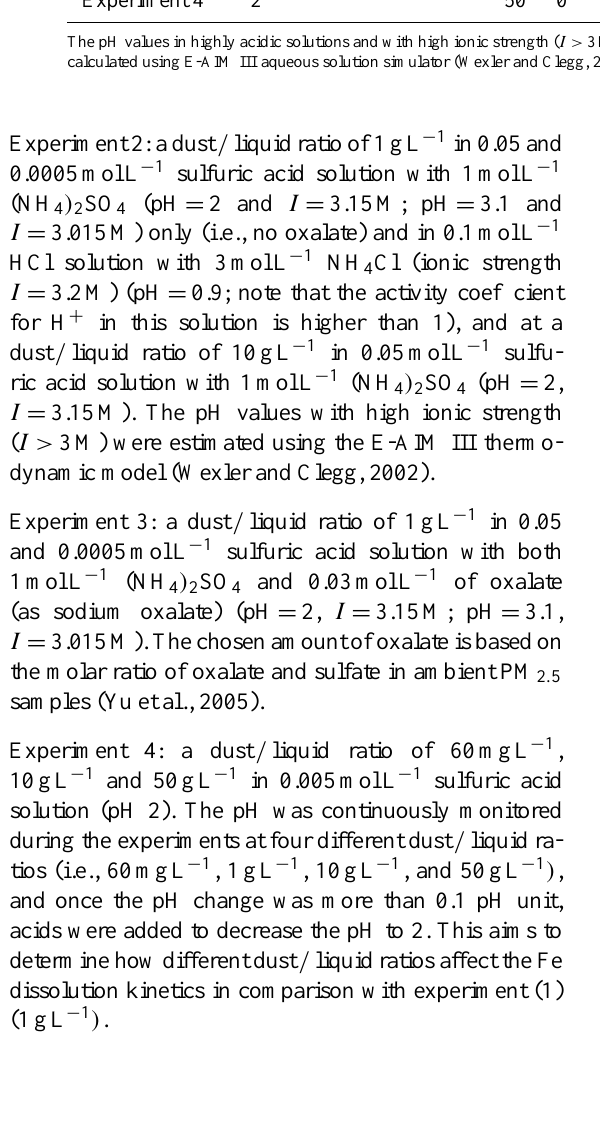
Table 1. Summary of Fe dissolution experiments performed in this study. Experiment pH Dust / liquid ratio (gL − 1 ) Ammonium salt Oxalate [H + ] (molL − 1 ) Experiment 1 Experiment 1 2.1 Experiment 2 Experiment 2 Experiment 2 Experiment 2 Experiment 3 Experiment